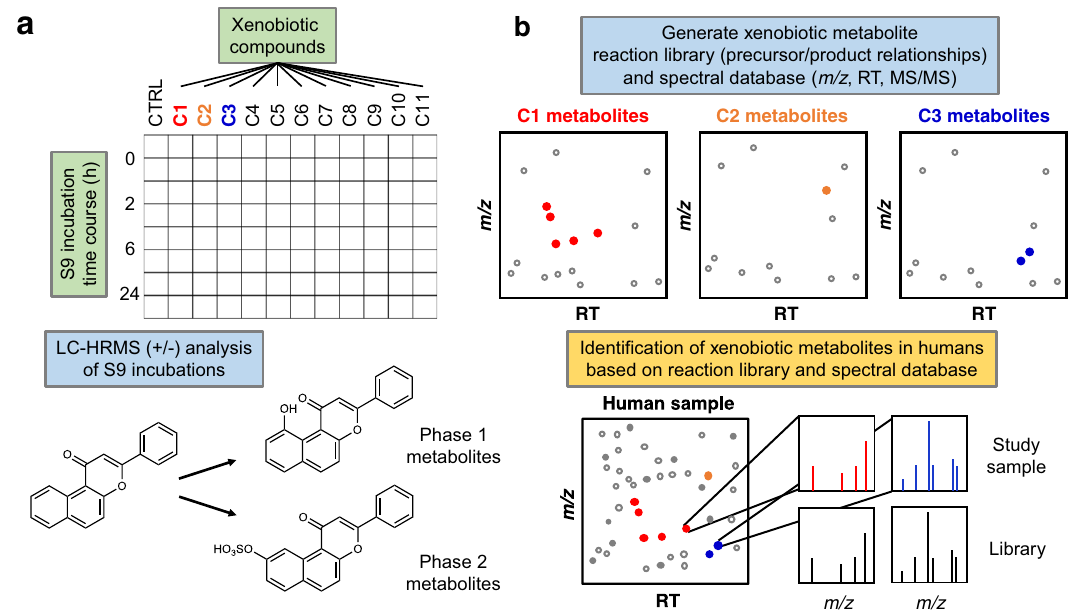
Fig. 1 Enzymatic generation of xenobiotic metabolites for mass spectrometry-based chemical identi fi cation. a Human liver S9 enzyme prepared in a 96- well plate format capable of performing multiple xenobiotic reactions in a single plate. Human liver S9 enzymes perform Phase I and II biotransformation reactions to generate xenobiotic metabolites or other downstream adducts from reactive intermediates. b High-resolution mass spectrometry (HRMS) analysis of enzyme-generated xenobiotic metabolites provides authentic metabolites for matching accurate mass m / z , retention time (RT), and MS 2 (if available) to detected metabolites in humans. Colored dots in each m / z RT dot plot represent spectral features that are identi fi ed from in vitro S9 reactions that could be matched to features detected in clinical or experimental studies. Co-occurrence of related xenobiotics in samples increases con fi dence in the identi fi cation of suspected exposure.